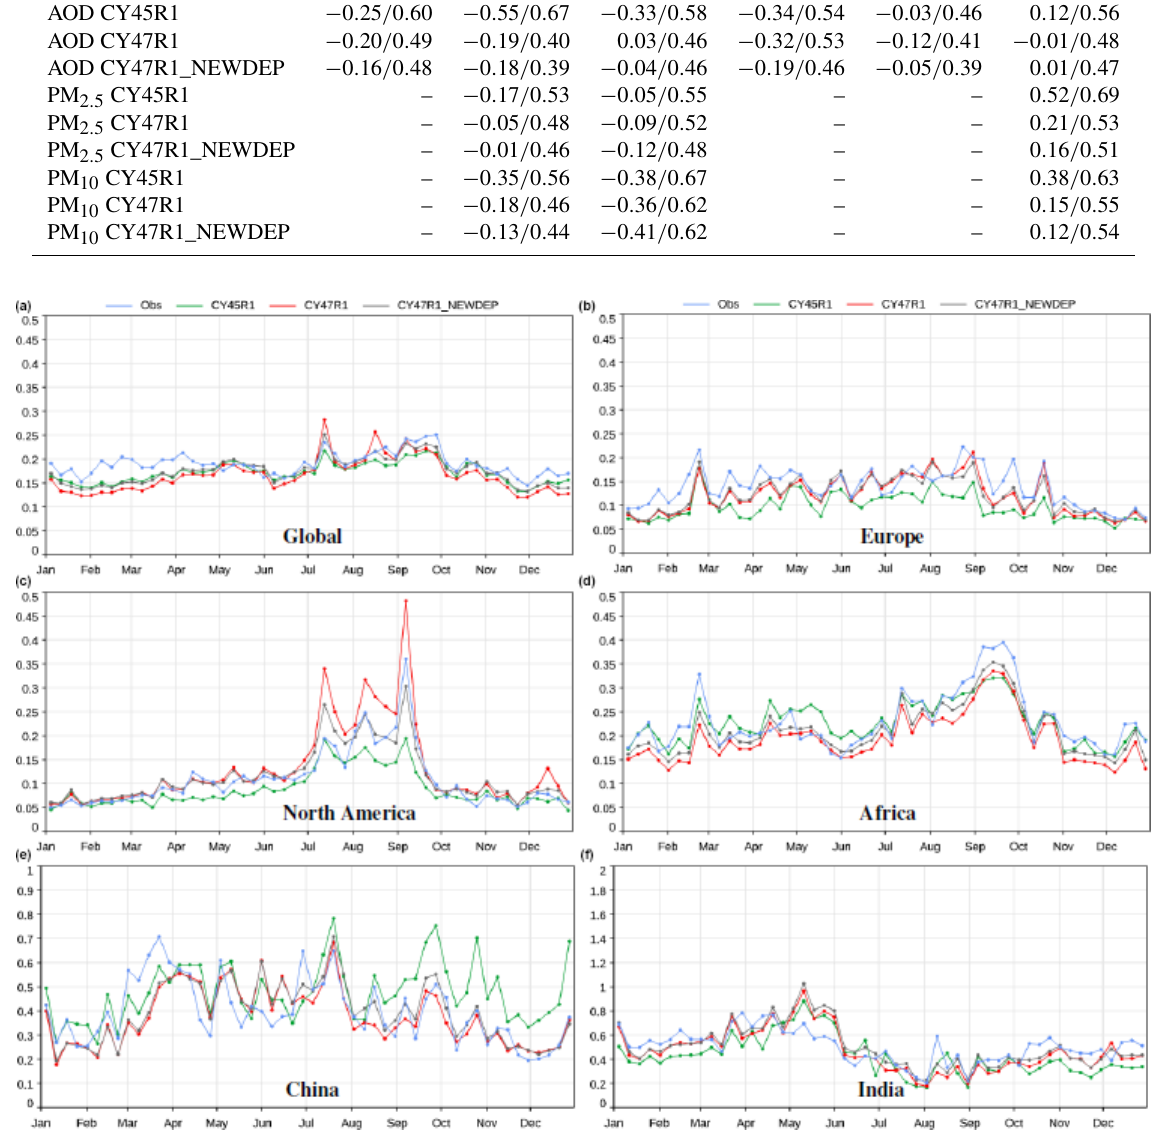
Figure 5. Global (a) and regional (b) – (f) simulated vs. observed level 2 weekly AOD at 500nm from AERONET averaged over 7d.